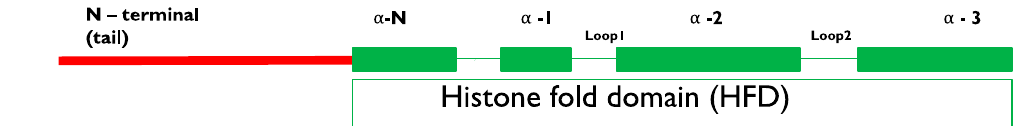
Figure 3. Typical schematic structure of the plant centromeric histone protein 3 ( CenH3 ) gene. There are currently two approaches for applying the CenH3–haploid inducer